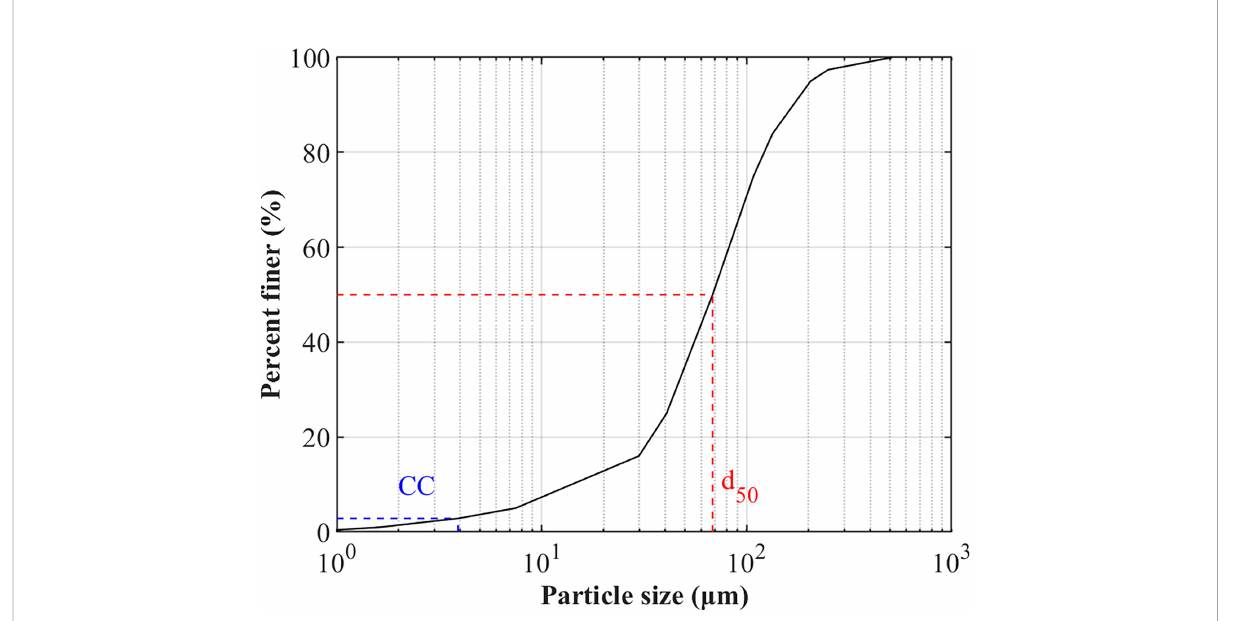
FIGURE 2 Cumulative particle size distribution of soil in the bottom boundary layer of the